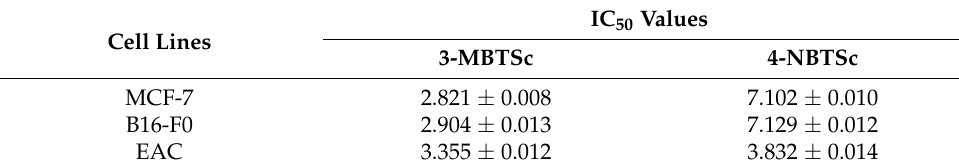
Table 3. IC 50 values of 3-MBTSc and 4-NBTSc compounds on different cancer cells.